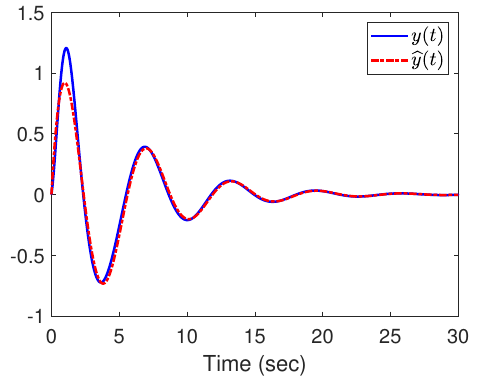
Figure 5. The trajectories of y ( t ) and (cid:98) y ( t ) .